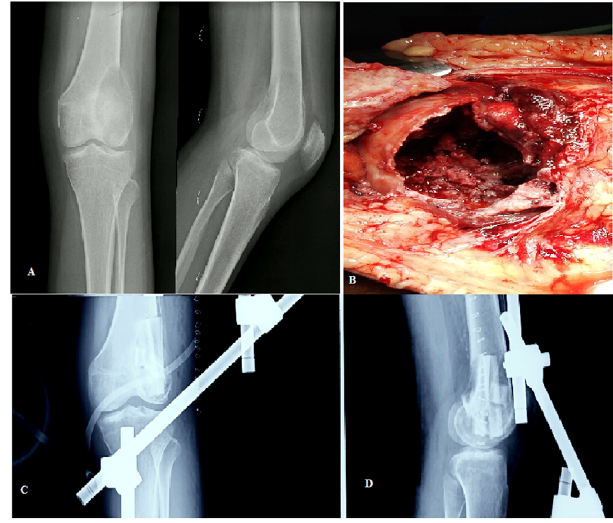
Figure 1. (A) Pre-operative radiographs showing lytic lesion destroying the lateral femoral condyle with a thin cortical rim; (B) Intra-operative picture of the defect after extended curettage; (C) and (D) Postoperative AP and lateral